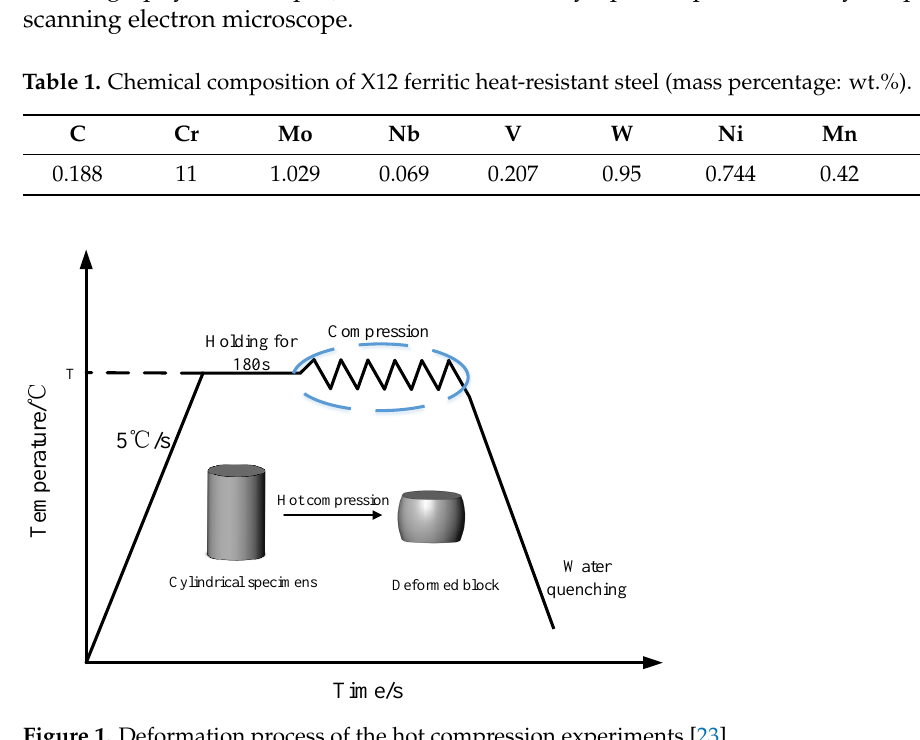
Figure 1. Deformation process of the hot compression experiments [23].